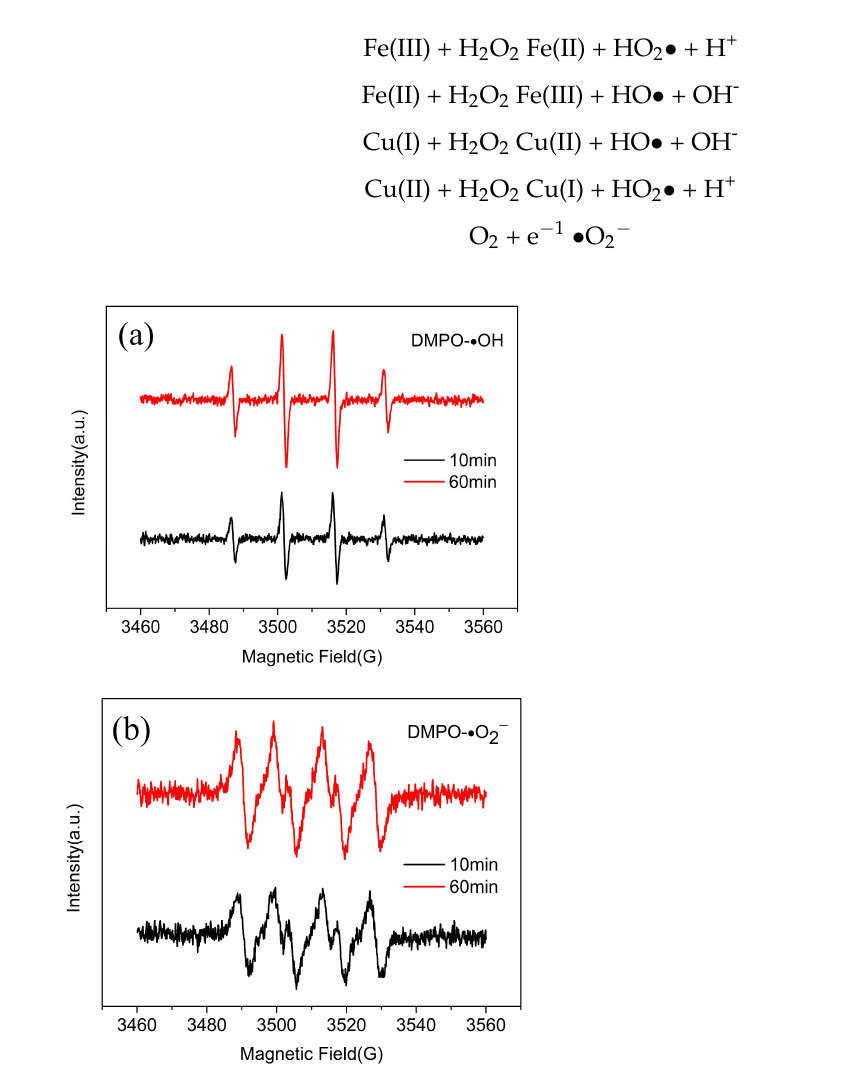
Figure 7. EPR spectra of ( a ) DMPO- • OH adducts and ( b ) DMPO- • O 2 − adducts.